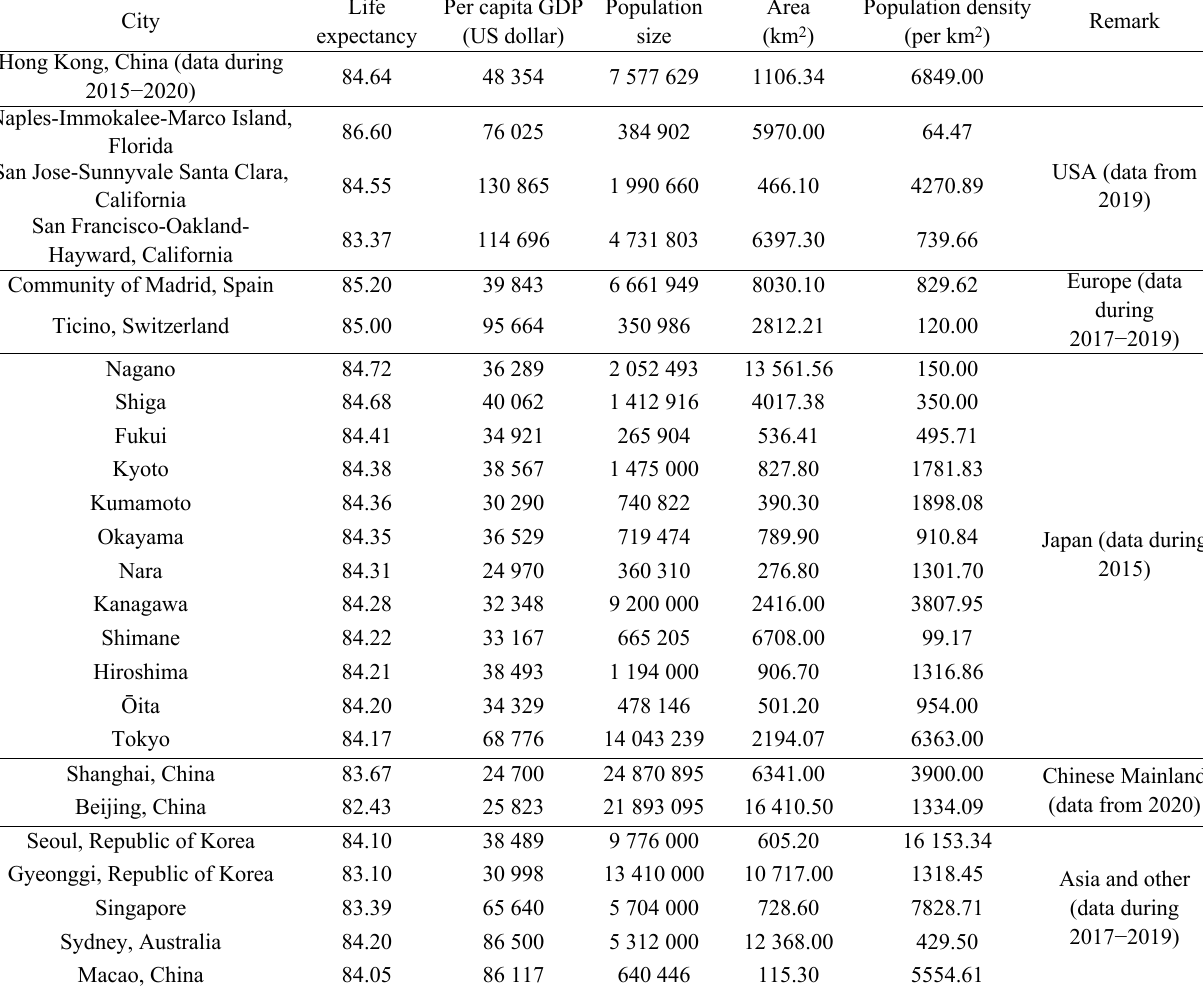
Table 1 Some possible cities for